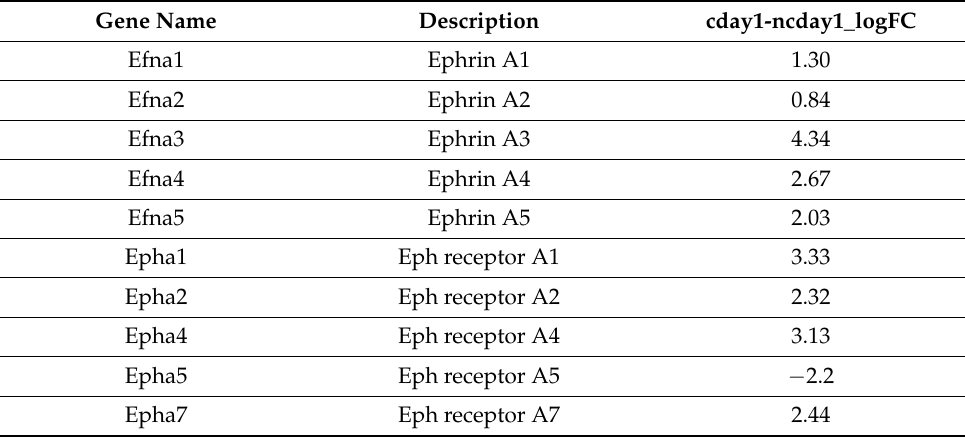
Table 2. Expression of ephrinA and its receptors, in chronic wounds.